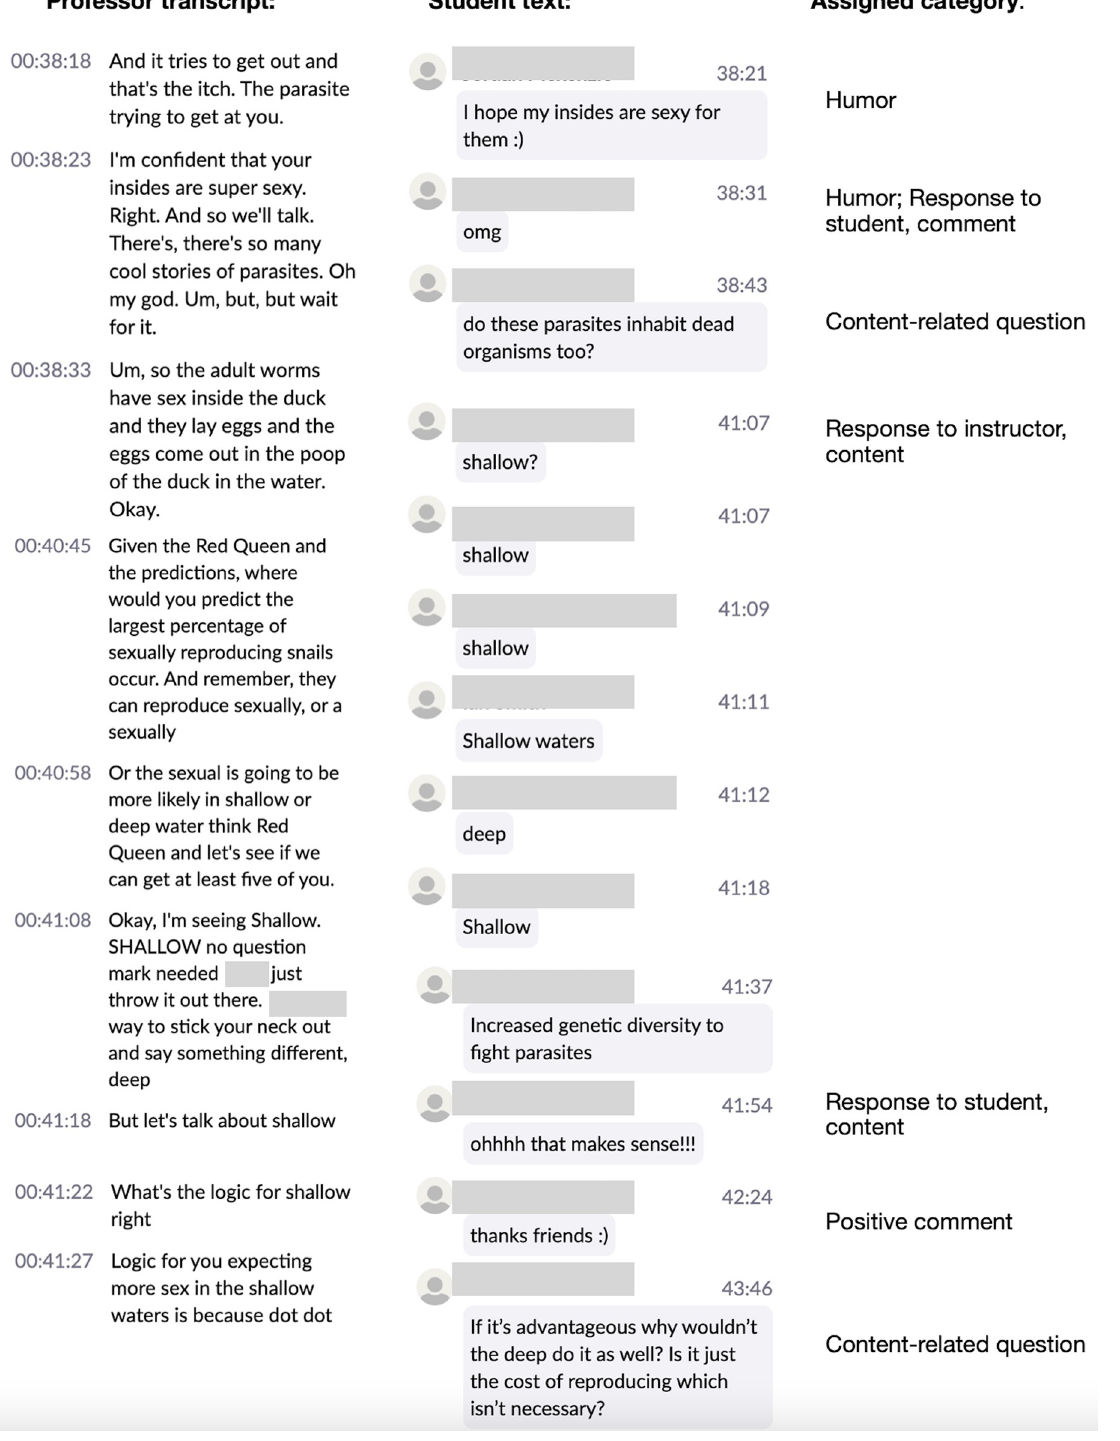
PLOS ONE | https://doi.org/10.1371/journal.pone.0273301 October 19,